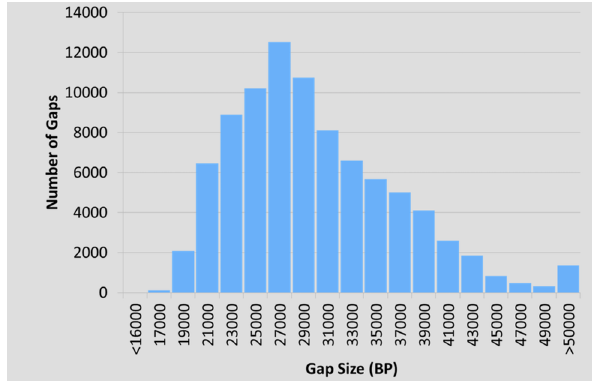
Fig 2. SNP GAP. The distribution of the gaps betweenthe 90,000 SNPs with respect to their locationin the bovineUMD 3.1 sequence.